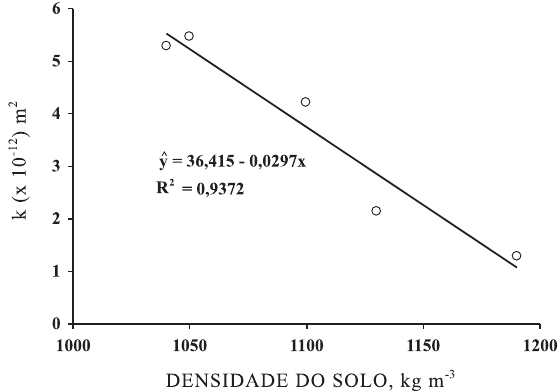
Figura 6. Influência da densidade do solo na permeabilidade ao ar de amostras de solo do estudo